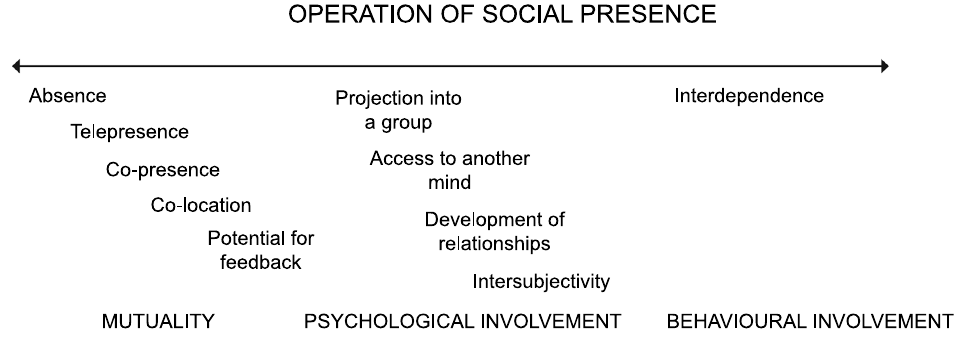
Figure 1. Continuum of social